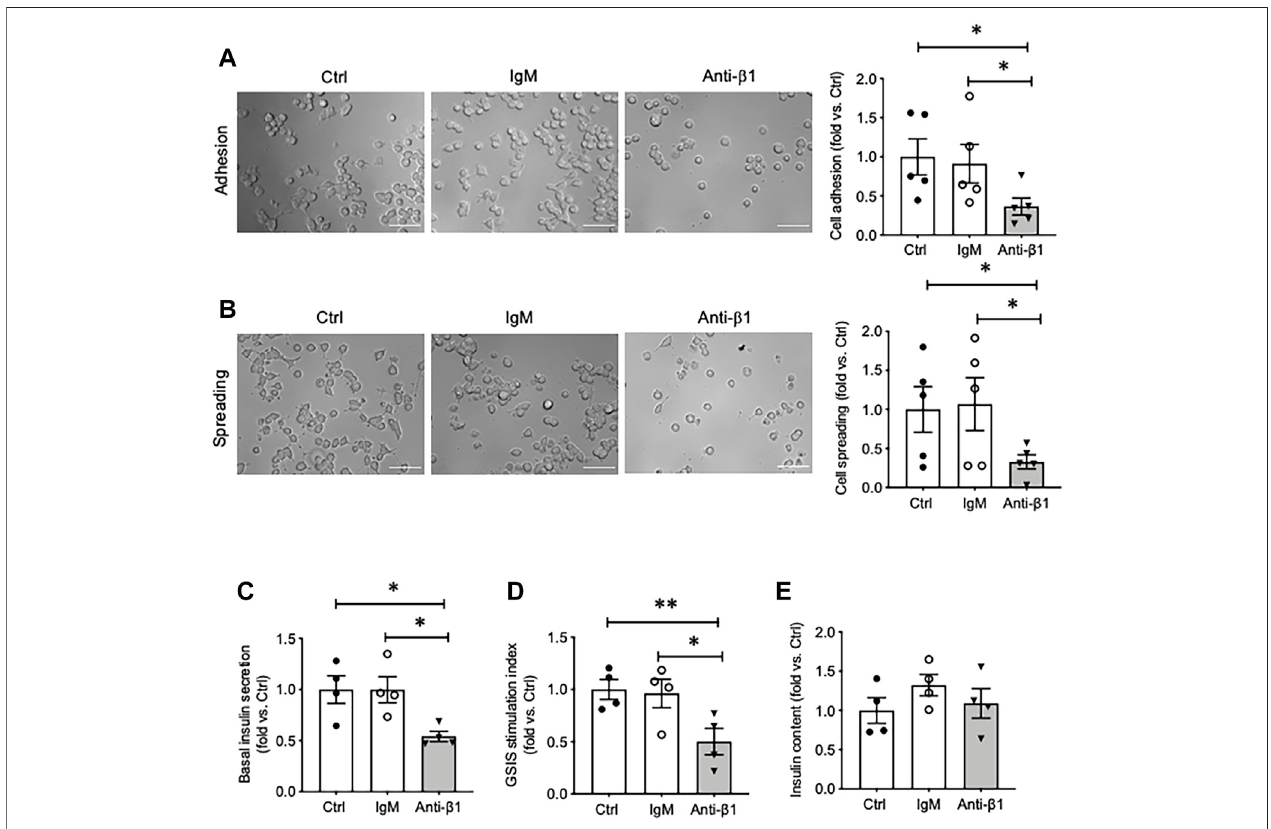
FIGURE5| Blocking β 1-integrinreducesINS-1 celladhesion,spreading,basaland glucosestimulatedinsulinsecretion.Phasecontrastimages andquanti fi cation analysis of cell (A) adhesion and (B) spreading. Scale bar: 10 µm. Data are expressed as fold change vs. untreated control (mean ± SEM; n = 5 experiments/group). (C) Basal insulin release, (D) glucose stimulated insulin secretion (GSIS) stimulation index, and (E) cellular insulin content from INS-1 cells cultured on collagen IV for 24 h treated with anti- β 1 or IgM, or untreated control. * p < 0.05, ** p < 0.01 vs. Ctrl. Data are expressed as mean ± SEM ( n = 4 experiments/group).